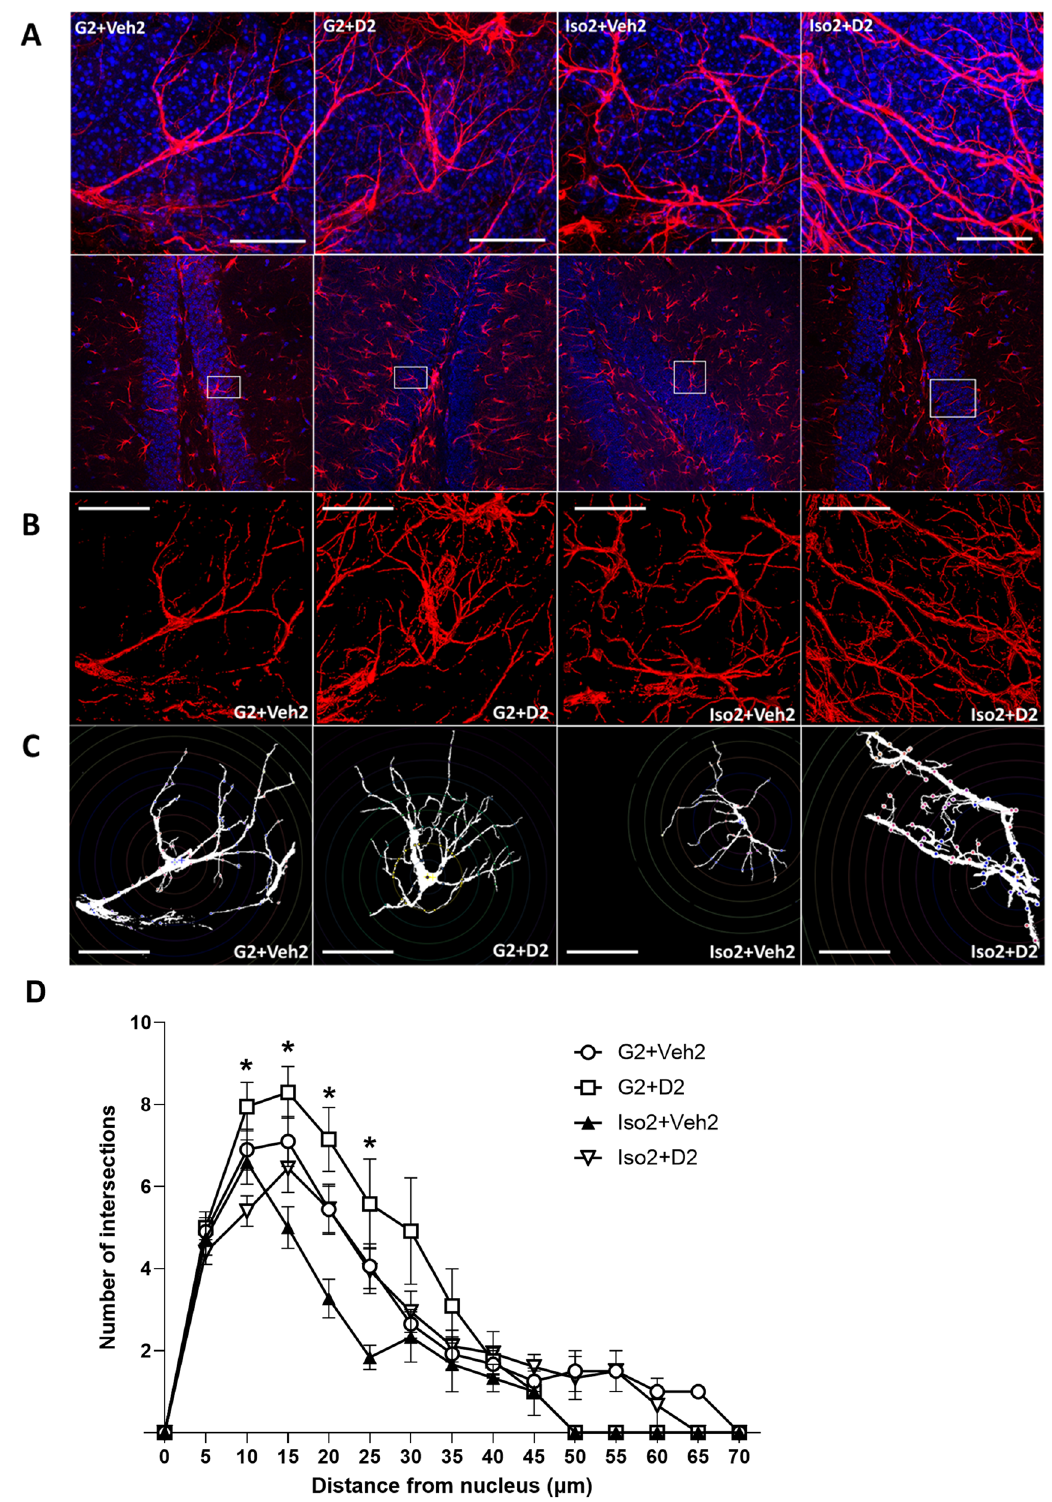
Figure 3. Astrocyte morphology in the dentate gyrus. ( A ) Upper: two-dimensional images of the astrocytes analyzed for morphology. Bottom: area of the DG containing the selected astrocyte. Blue = DAPI, nucleus; red = GFAP, astrocytes. Scale bar = 20 µm. ( B ) Three-dimensional images of astrocyte morphology. Scale bar = 20 µm. ( C ) Binary representation of astrocytes used for morphological complexity. Scale bar = 20 µm. ( D ) Quantification of morphological complexity (Sholl analysis). Two-way ANOVA with multiple comparisons, Holm-Sidak method. G2 + Veh2: 2-week grouped plus 2-week grouped with vehicle treatment; G2 + D2: 2-week grouped plus 2-week grouped with DHM administration; Iso2 + Veh2: 2-week SoIso plus 2-week SoIso with vehicle treatment; Iso2 + D2: 2-week SoIso plus 2-week SoIso with DHM administration. 5 astrocytes analyzed per mouse. N = 4 mice per group. *, P ≤